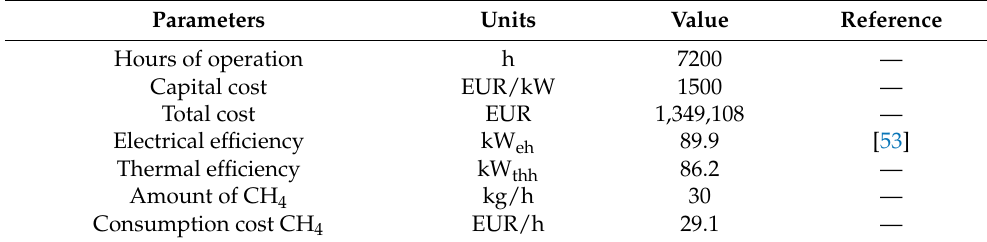
Table 8. Initial assumptions for the SOFC unit.